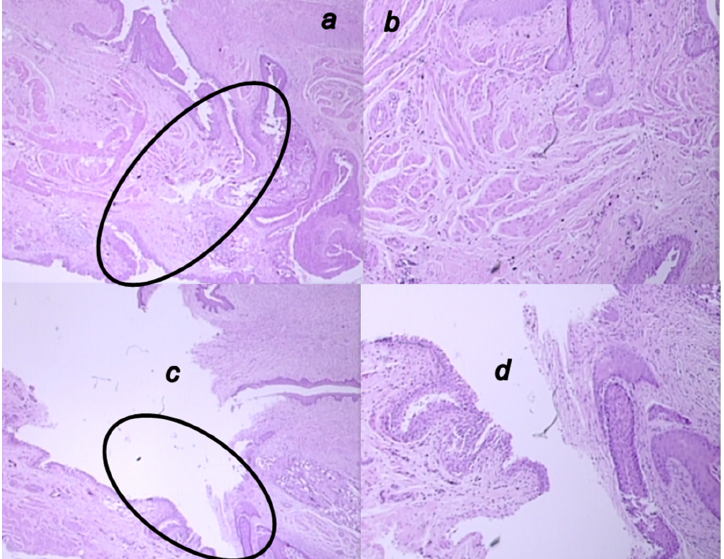
Figure 13. Microscopic presentation of 6 weeks-vesicovaginal fistula, after the 4 weeks-therapy of fistulous rats in the BPC 157 treated rats ( a , b ) and control rats ( c , d ). ( a , b ) Significant neovascularization with formation of new blood vessels (circle) and mature granulation tissue is visible in the BPC 157-rats (HE; ×20 ( a ), ×100 ( b )). ( c , d ). Visible open vesicovaginal fistula in control (circle) with moderate inflammation, mature epithelialization, and fully formed subepithelial collagen tissue in the controls (HE; × 20 ( c ), × 100 ( d